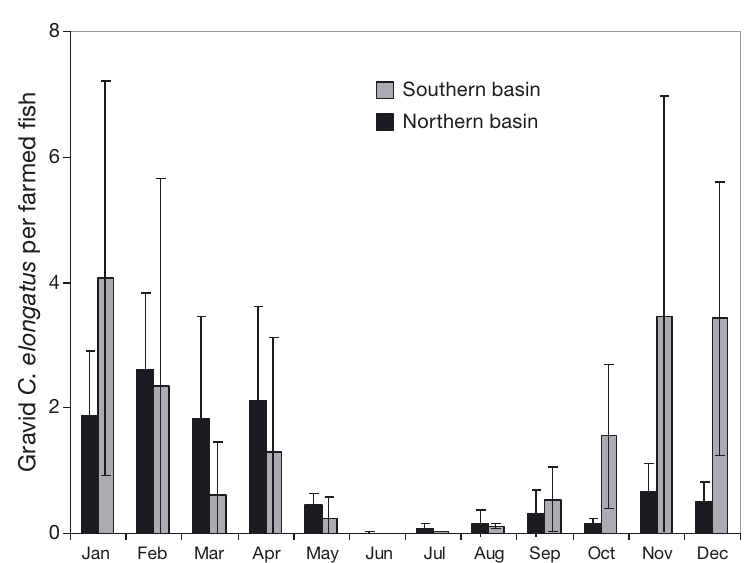
Fig. 7. Monthly averaged abundance of gravid Caligus elongatus during 2 farming cycles (2010−2014) at a salmon farm in the southern basin in Sun- dalagið (grey bars) and a farm in the northern basin (black bars). Error bars: SE between